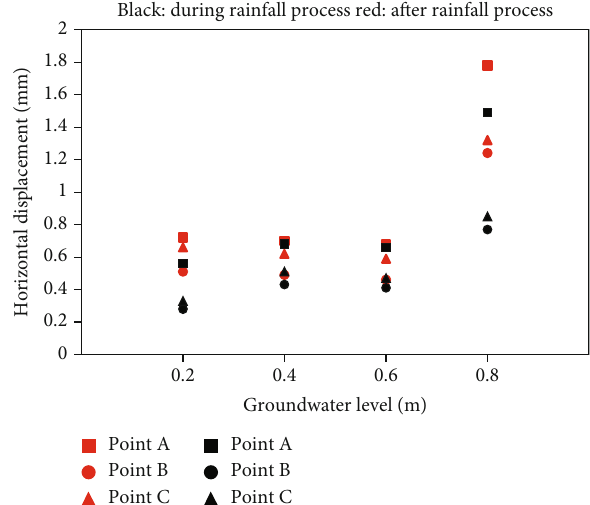
Figure 8: Displacement of slope reference points A, B, and C after the end of rainfall.